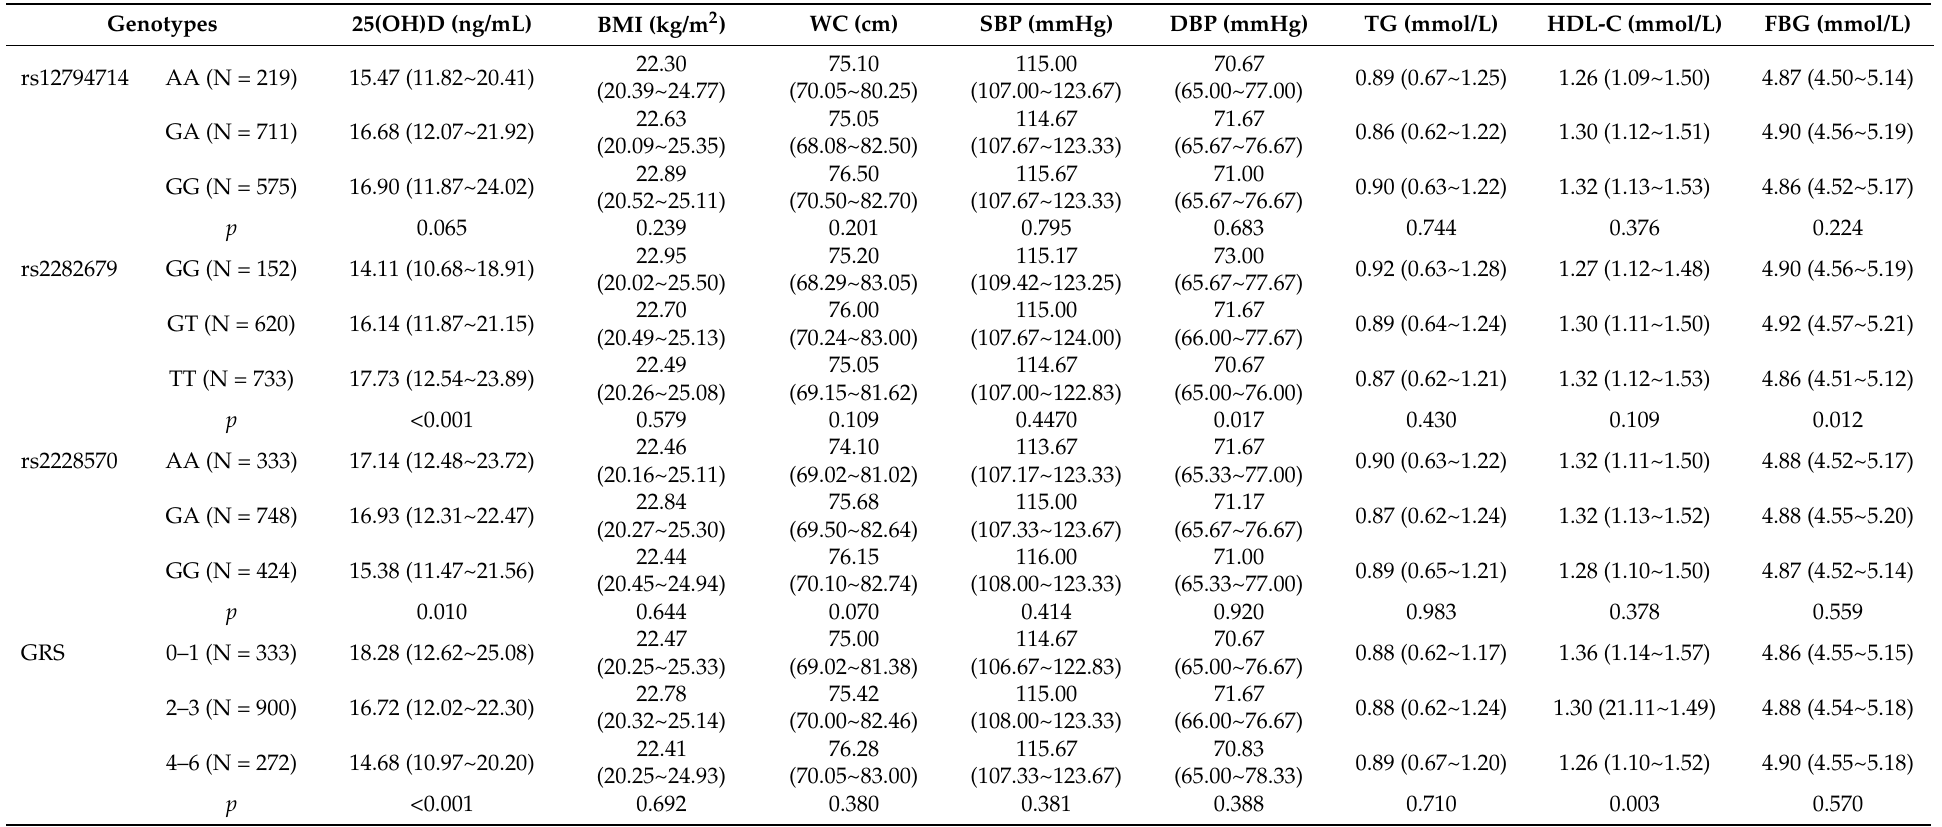
Table 3. Relationships of vitamin D related SNPs and the MetS’s